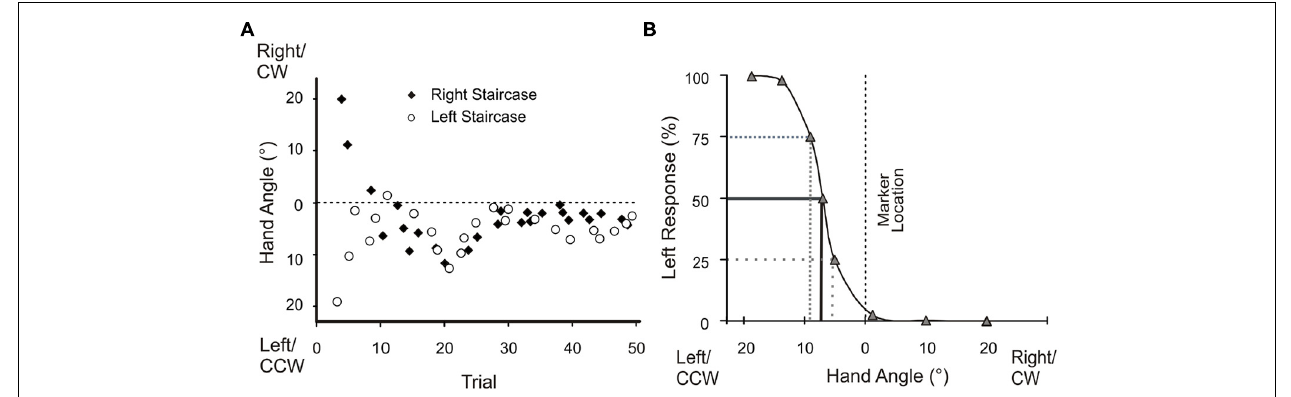
FIGURE 3 |Angular hand position during proprioceptive estimate trials and percentage of left responses for the 0 ◦ visual reference marker for a single subject. (A) The left and right staircases began with a subject’s hand placed 20 ◦ from either side of the reference